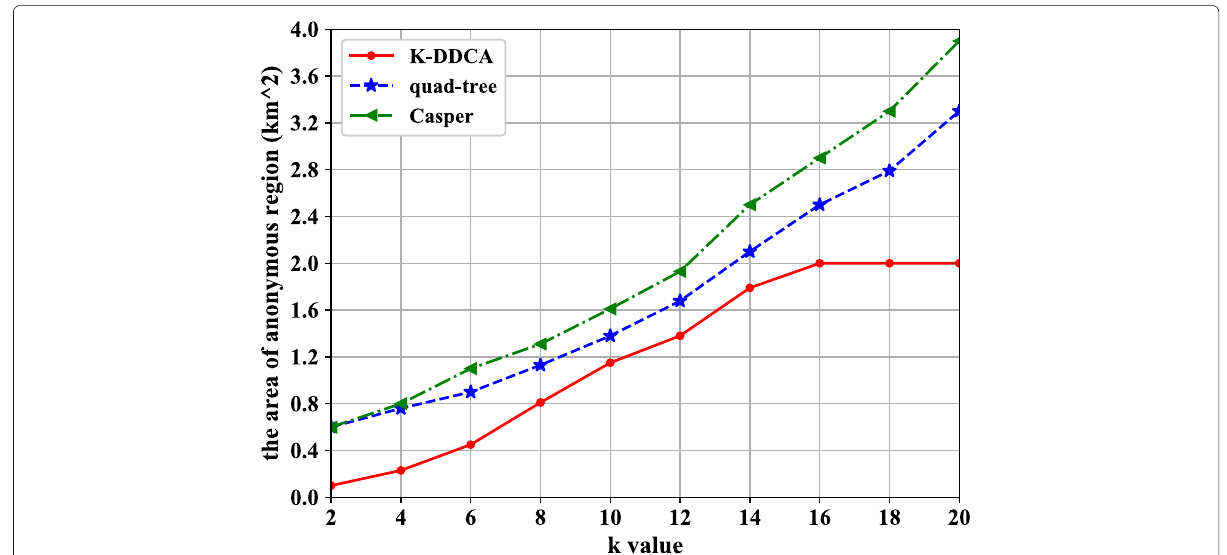
Fig. 7 Relationship between the area of anonymous region and k value. It shows that as the k value increases, the area of the anonymous region constructed by the K-DDCA algorithm is appropriate compared to the other two algorithms